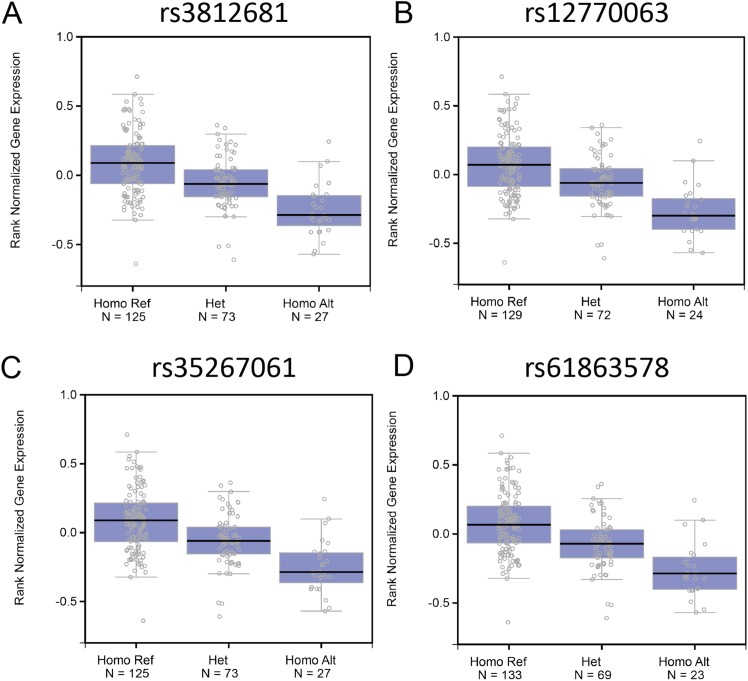
The association of the genotypes of the SNPs with Fank1 mRNA expression.eQTL analysis of Fank1 mRNA expression level for genotypes Homo Ref, Het and Homo Alt at (A) rs3812681, (B) rs12770063, (C) rs35267061 and (D) rs61863578.